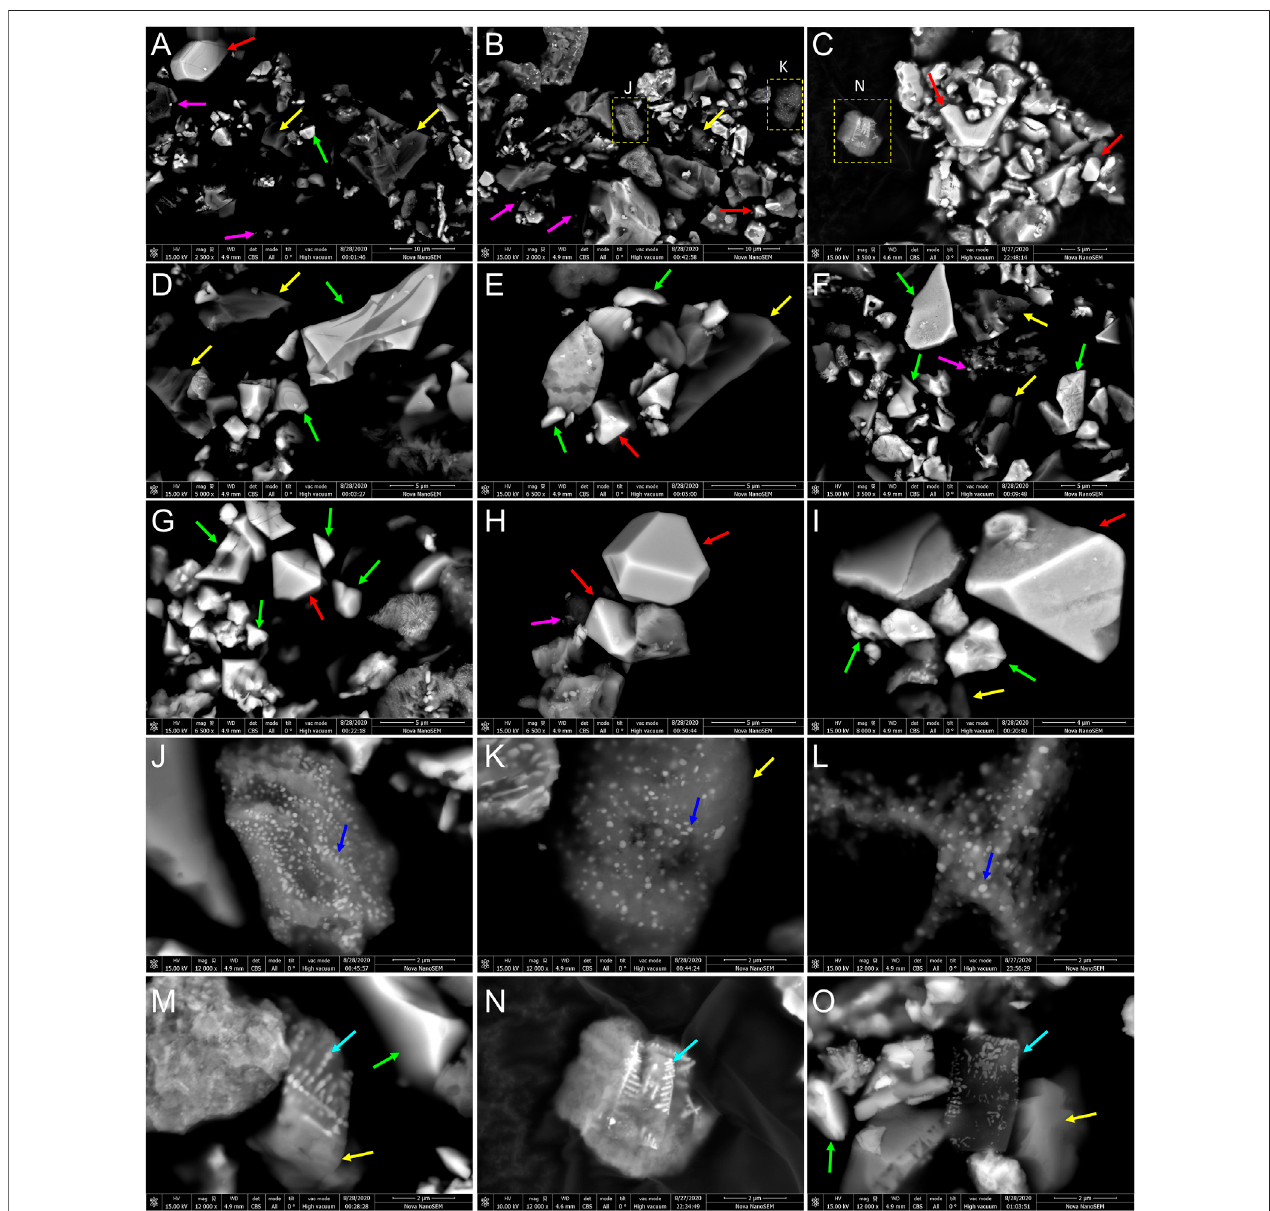
FIGURE 4 | Backscattered SEM images of magnetic mineral extracts. Fe-Mn silicate particles (yellow arrows), angular titanomagnetite particles (green arrows), octahedral or truncated octahedral titanomagnetite particles (red arrows), silicate-hosted magnetite particles (blue arrows), silicate-hosted dendritic magnetite particles (cyan arrows), and individual nanometer-sized magnetite particles (purple arrows) are recognized from SEM morphological observations and SEM-EDXS elemental mapping ( Supplementary Material S1 ).